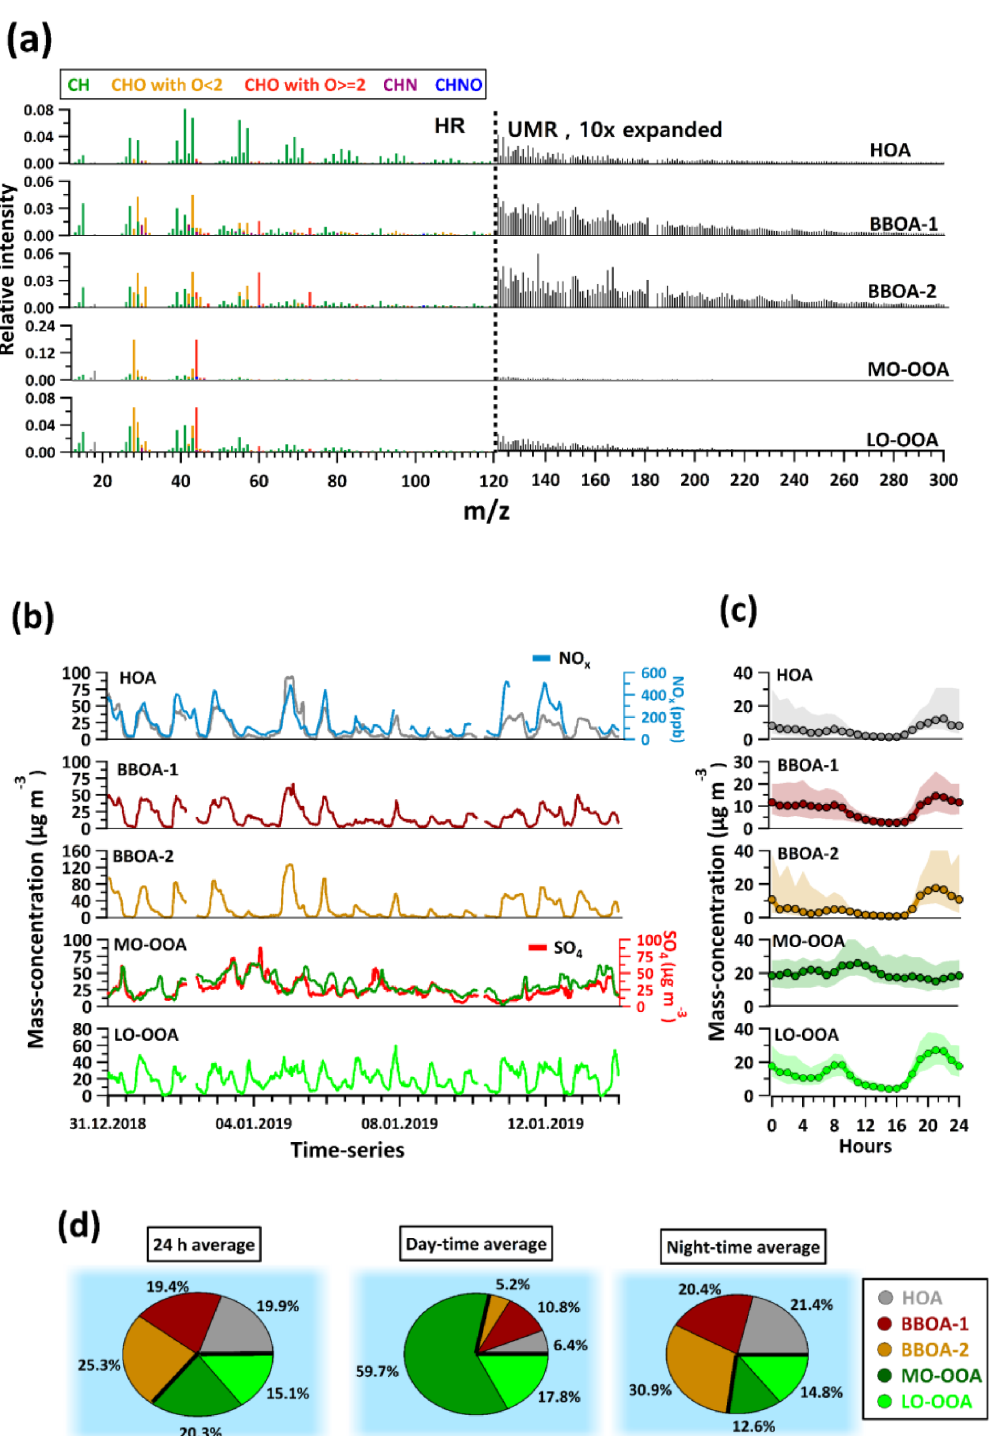
Figure 1. (a) Mass spectra from AMS PMF factors. The mass spectra are divided into two regions, i.e. one from m/z 12 to 120 (individual ions from HR peak fitting) and one from 121 to 300 (integer m/z integration). The mass spectra are coloured according to different families as mentioned in the legend. (b) Factor time series from AMS PMF results, together with selected reference species. (c) Diurnal trends with interquartile ranges (shaded areas) of the AMS factors. These are drawn at an hourly time resolution. (d) Pie charts showing fractional contributions of AMS factors as the 24h average, as well as for daytime (10:00–16:00LT) and nighttime